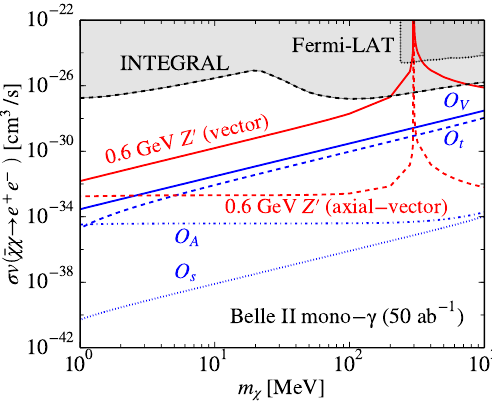
Figure 13 . Belle II 90% C.L. upper bound from the mono-photon channel with 50 ab − 1 data on the DM annihilation cross section σv (¯ χχ → e + e − ) evaluated at v =220 km/s, and the constraints DM from Fermi-LAT [94] and INTEGRAL [95]. The blue lines correspond to the limits in figure 1 on EFT operators: O (dot-dashed), O (solid), O (dotted), and O (dashed). The red solid and A V s t dashed lines correspond to the m = 0 . 6 GeV models in figure 2 and 3 Z 0